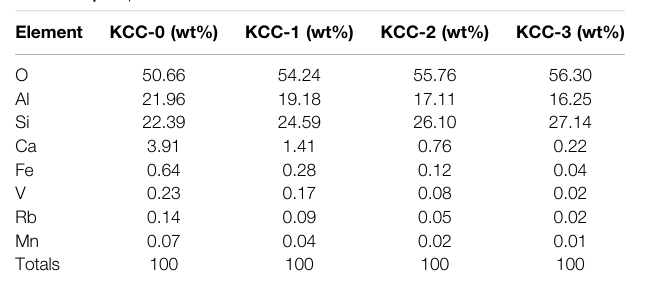
TABLE 1 | Properties of raw materials.